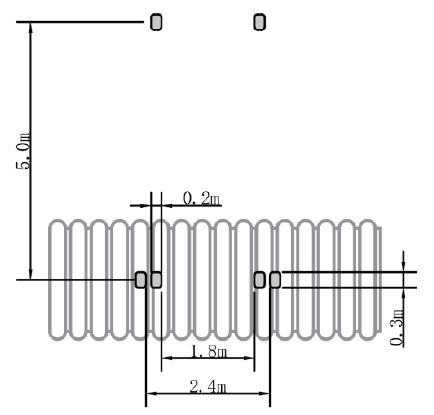
Figure 9. Location and parameters of wheel loads.